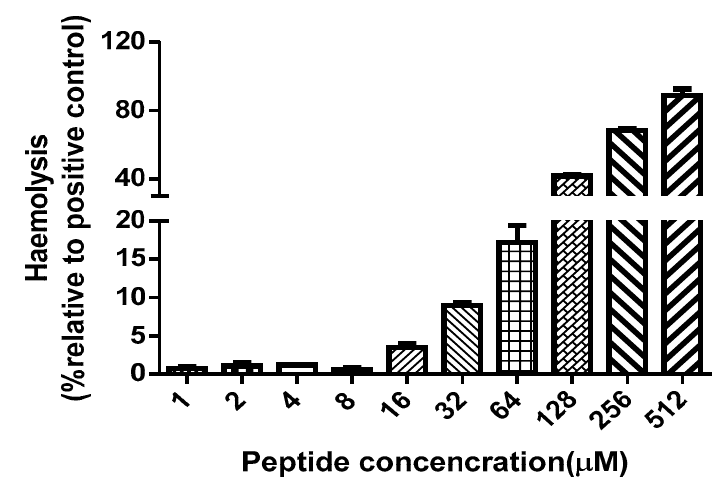
Figure 6. The haemolysis activity of Der-PS4 was tested using horse red blood cells in a range of concentrations from 1 µM to 512 µM. Positive control group was treated with 1% Triton X-100 lysis buffer. Data represent means ± SEM (standard error of the mean) of 5 replicates.